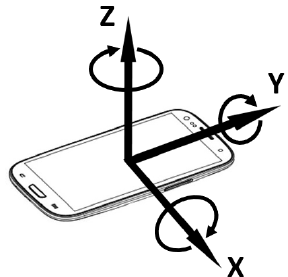
Figure 3. The three measures returned by the accelerometer correspond to the orientation of the smartphone in three dimensional